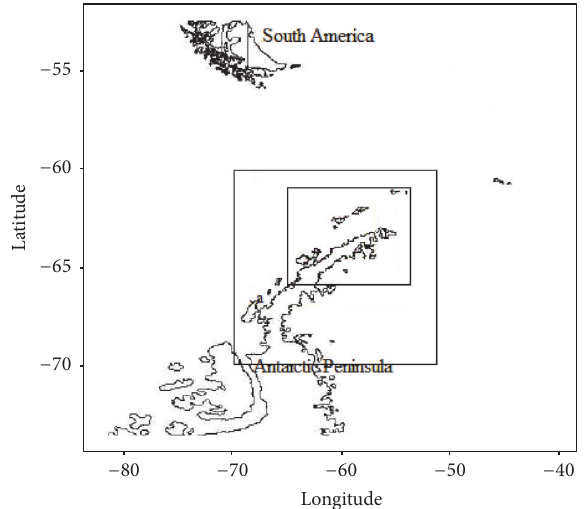
Figure 1: Map showing the domains of the simulations with respect to the Antarctic